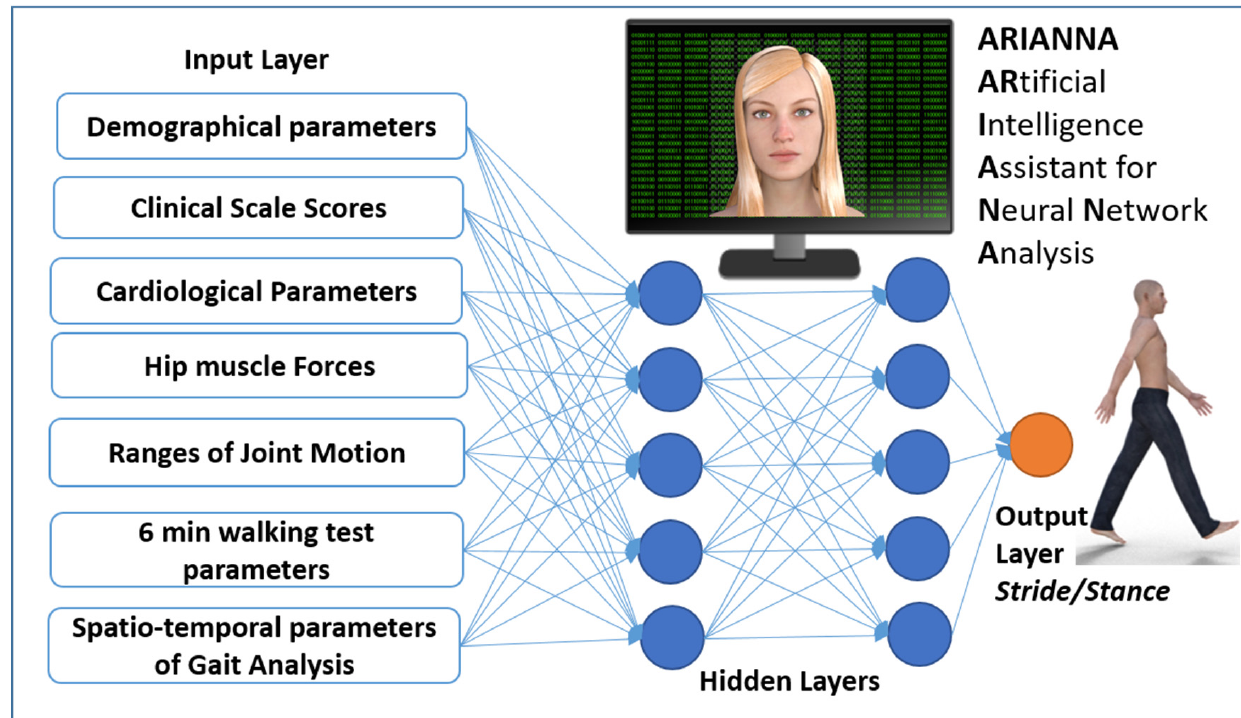
Figure 1. Schematic representation of the Artificial Neural Network used in this study.